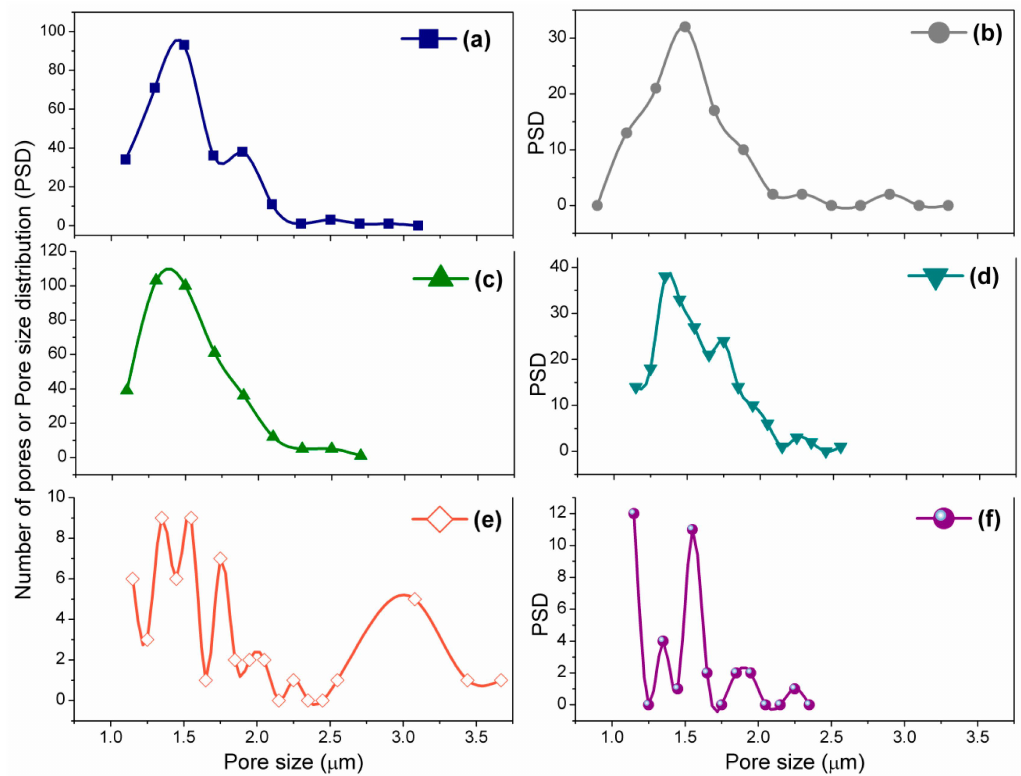
Figure 5. Pore size distributions (PSDs) of ( a ) unsintered; ( b ) S450; ( c ) S650; ( d ) S850; ( e ) S1050; and